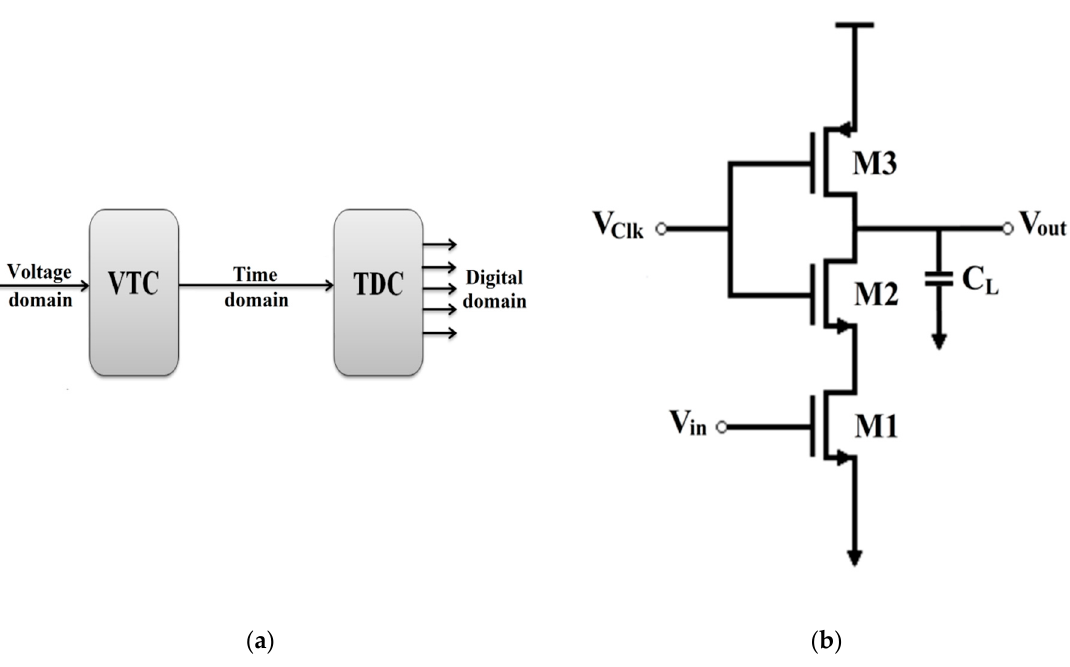
Figure 1. ( a ) Time-based analog-to-digital converter (ADC) architecture, and ( b ) simple current starving inverter.